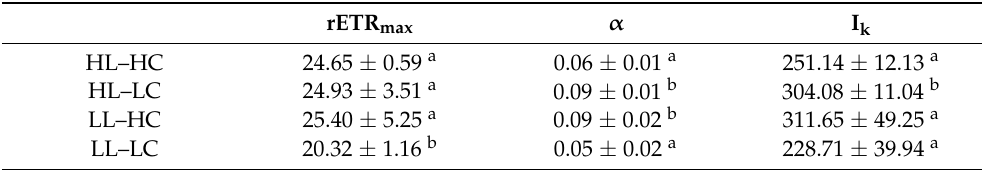
Table 2. The maximum rETR (rETR max ), electron transport efficiency ( α ), and saturating irradiance (I k ) of Porphyra yezoensis under different CO 2 concentrations and light treatments. Data are the means ± SD ( n = 3). Different letters ( a and b ) indicate the significant difference ( p < 0.05) of different light intensity under the same CO 2